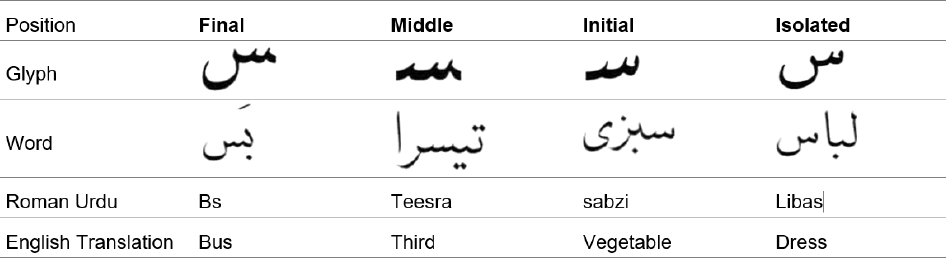
Figure 1. Different styles of an Urdu character used in cursive words. Nastaleeq